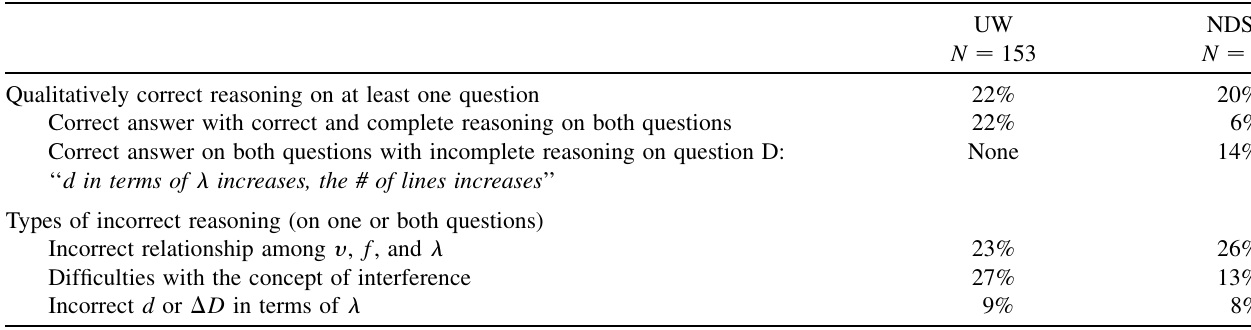
TABLE II. Summary of results from questions D and E of the two-source interference problem after all instruction on two-source interference. Indented categories are subcategories of the preceding major